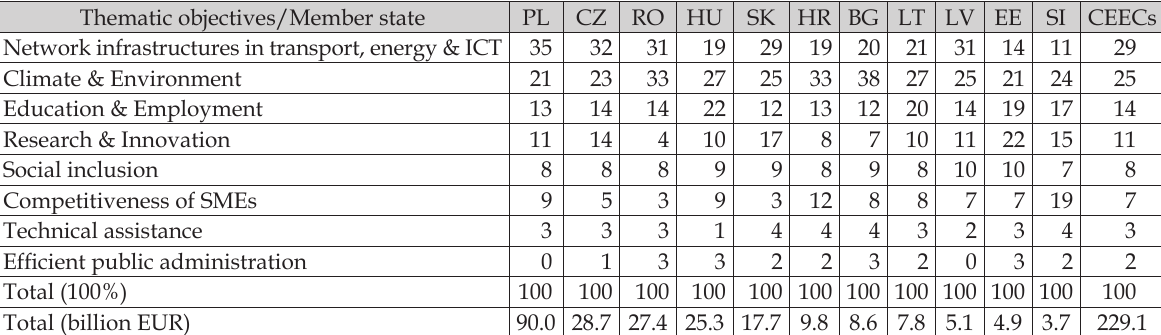
Table 2. The structure (% from budget of Member State) of the Cohesion policy budget by thematic objectives in CEECs 2014-2020, based on finances